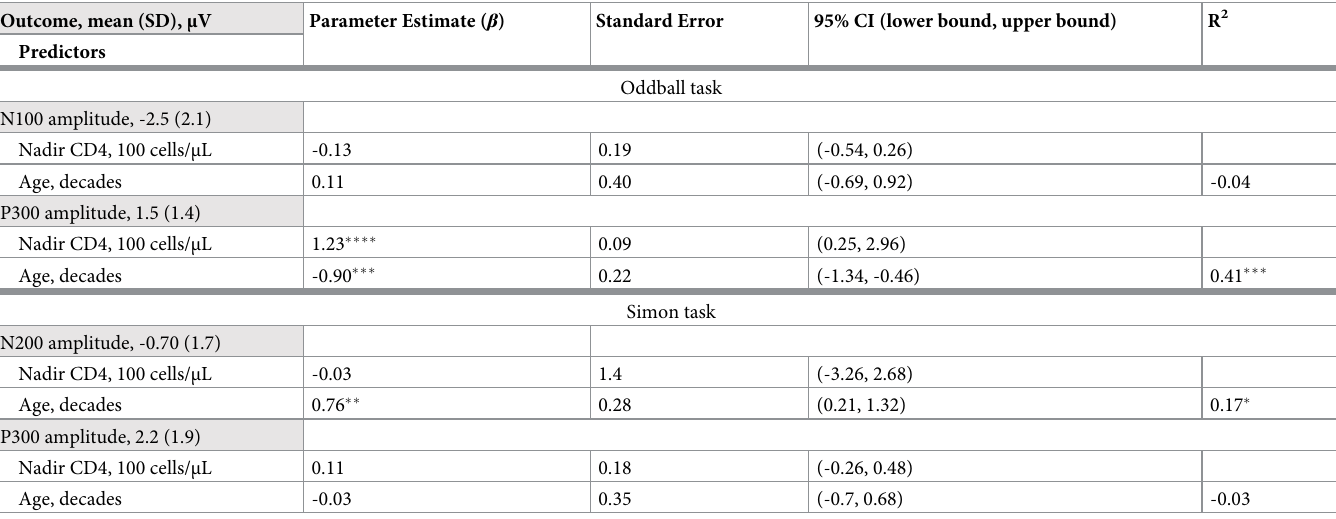
Table 3. Multiple linear regressions predicting ERP amplitudes.